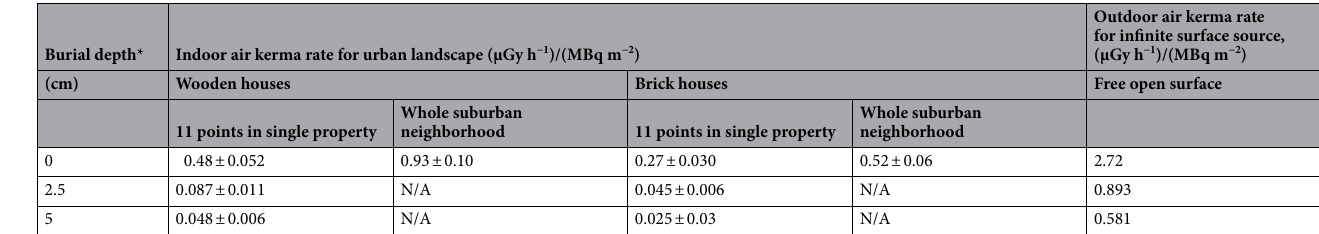
Table 1. Indoor air kerma rate per ground deposition of 137 Cs (± 1 SEM) from a surrounding surface deposition, as simulated by 8 **, and the corresponding air kerma rate 1 m above an infinite surface deposition (taken from 21 ), expressed in units of (μGy h −1 )/(MBq m −2 ). SEM = standard deviation of the mean. *Standard soil as defined by 22 . **Disregards the contribution from the roofs of the residential buildings. According to 23 , with a fresh fallout, the roof contribution to the indoor air kerma rate, K air,in , can vary from 22 to 33% of the contribution from the surrounding gardens and streets, depending on whether the 137 Cs fallout is wet or dry